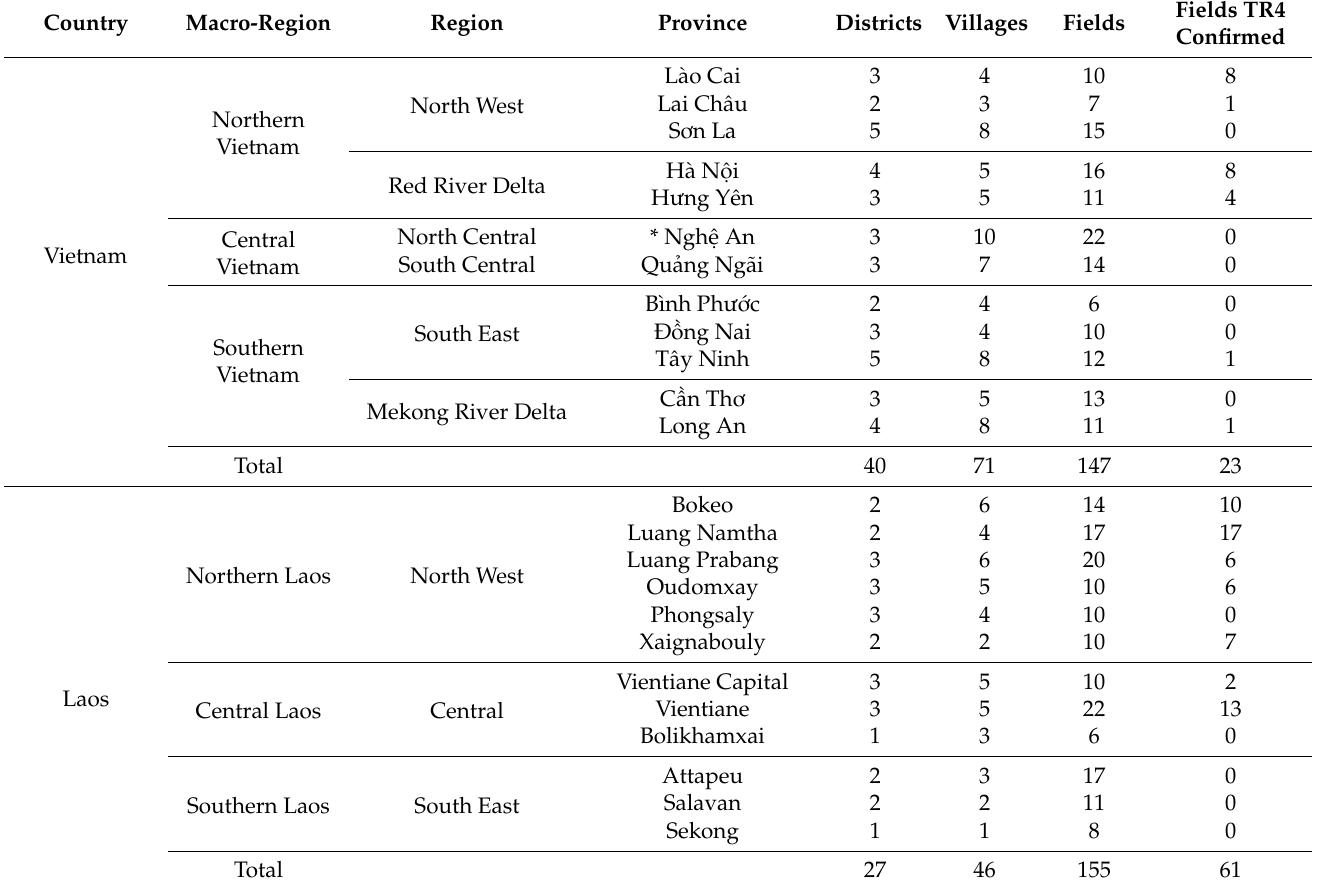
Table 1. Overview of the 2018 survey. The number of districts, villages and fields are indicated for each province surveyed. The number of fields in which Fusarium oxysporum f. sp. cubense TR4